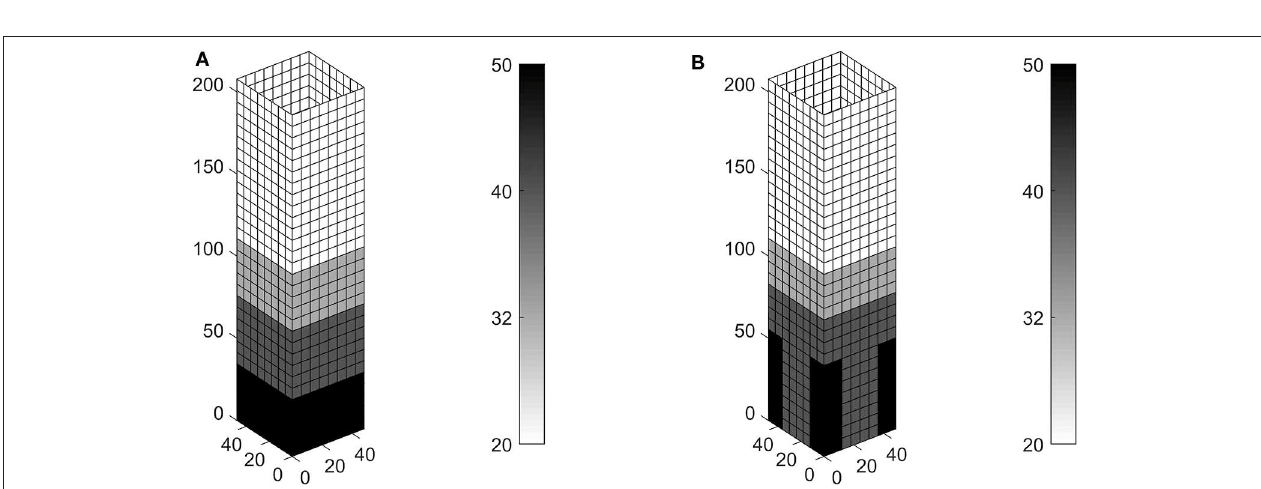
2 elements, W 28,267kN. × =